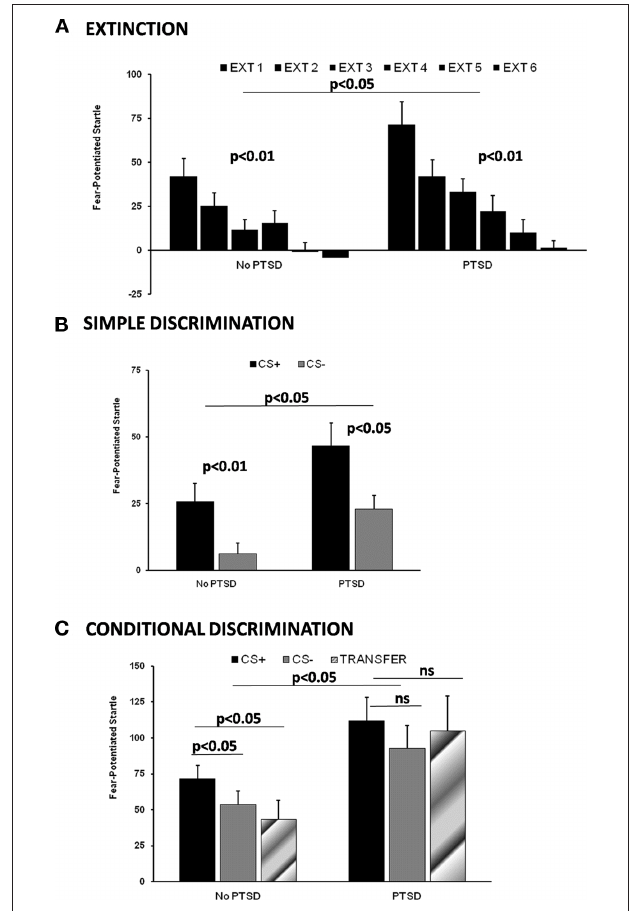
Figure 2 | Fear-inhibition data from our studies on a traumatized civilian population. (A) Extinction, adapted from (Norrholm et al., 2011); (B) Simple Discrimination, adapted from (Norrholm et al., 2011); (C) Conditional Discrimination, adapted from (Jovanovic et al., 2010b). EXT, Extinction Block; PTSD, Posttraumatic stress disorder; CS + , Reinforced Conditioned Stimulus; CS − , Non-reinforced Conditioned